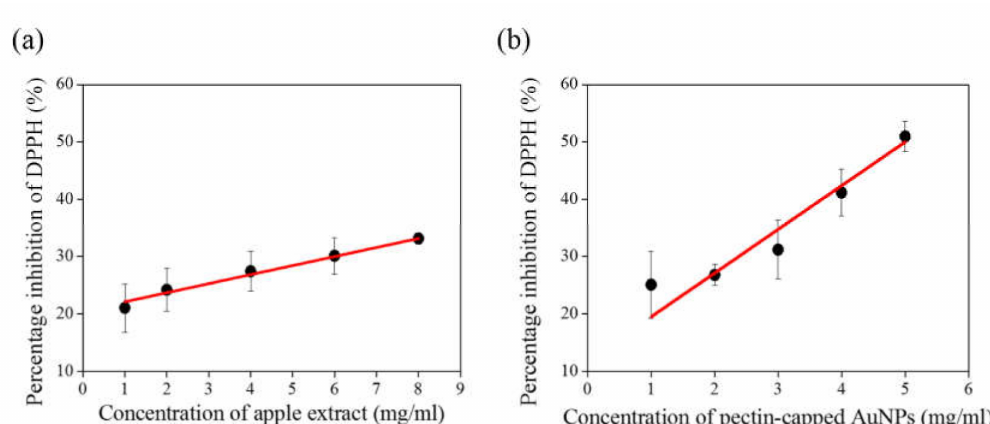
Figure 7. Comparison of scavenging ability of ( a ) apple extracts and ( b ) AuNPs encapsulated in carbon nanosheets at di ff erent concentrations.